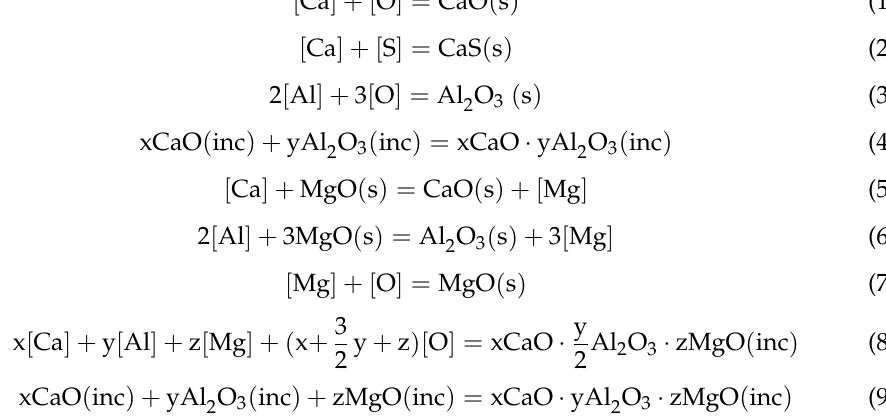
Commented [M1]: Please revise Figure 3 with this one.